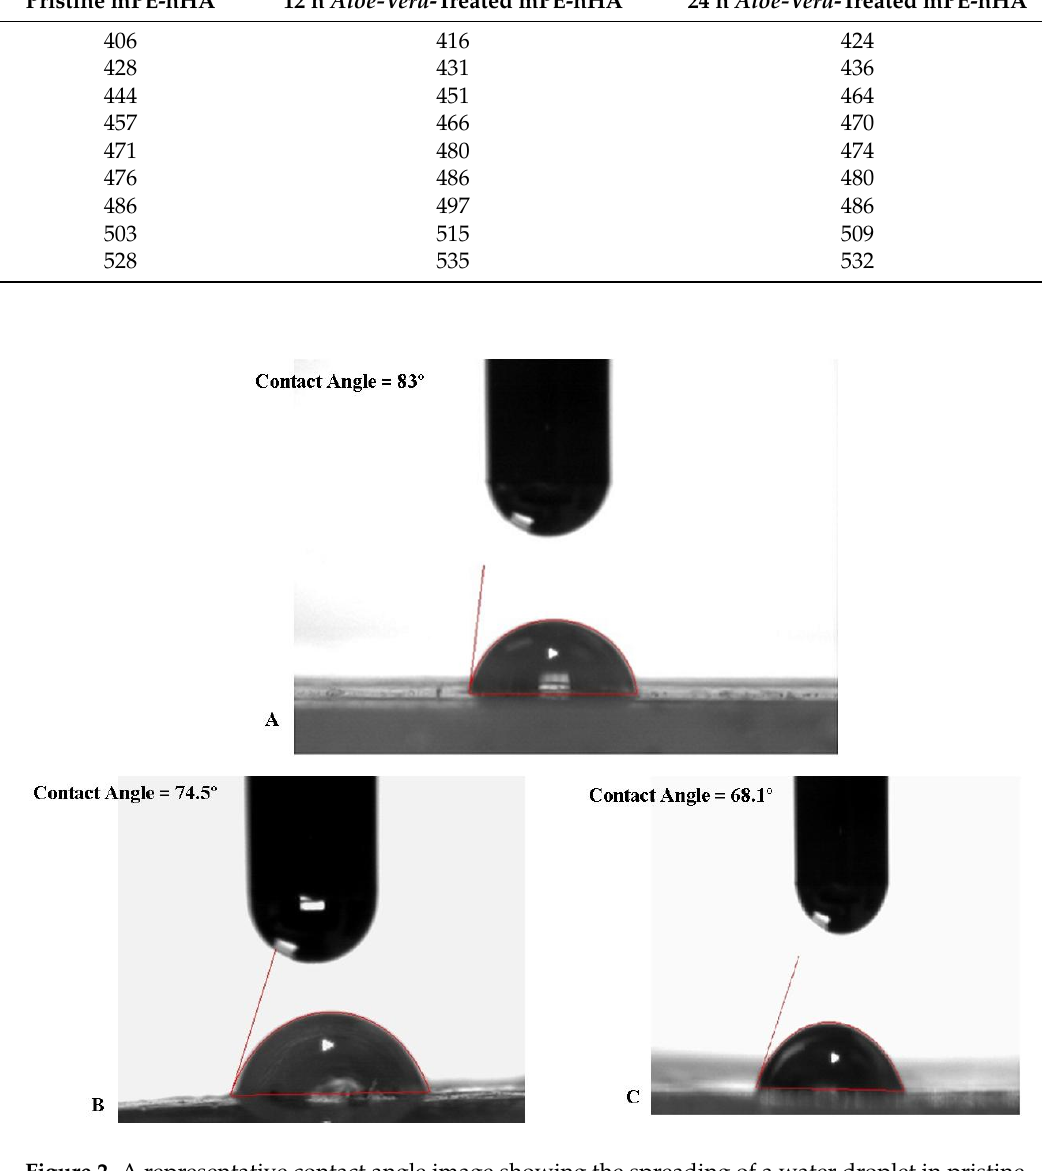
Figure 2. A representative contact angle image showing the spreading of a water droplet in pristine mPE ‐ nHA, and 12 and 24 h Aloe vera dip ‐ coated mPE ‐ nHA ( n = 3), respectively.